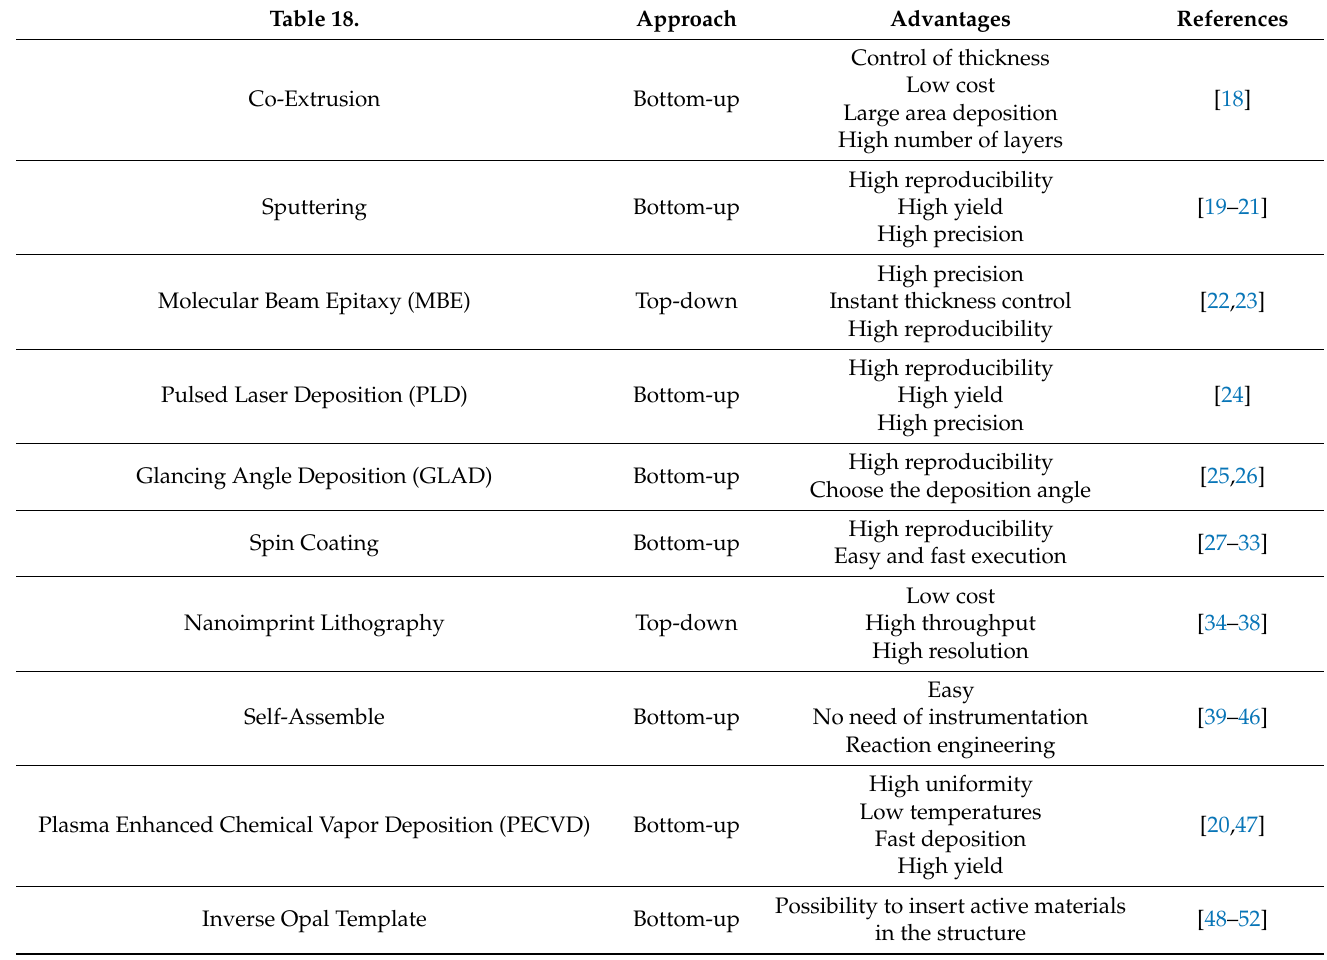
Table 1. Main manufacturing techniques of photonic crystals. The type of approach and the most significant advantages are indicated for each